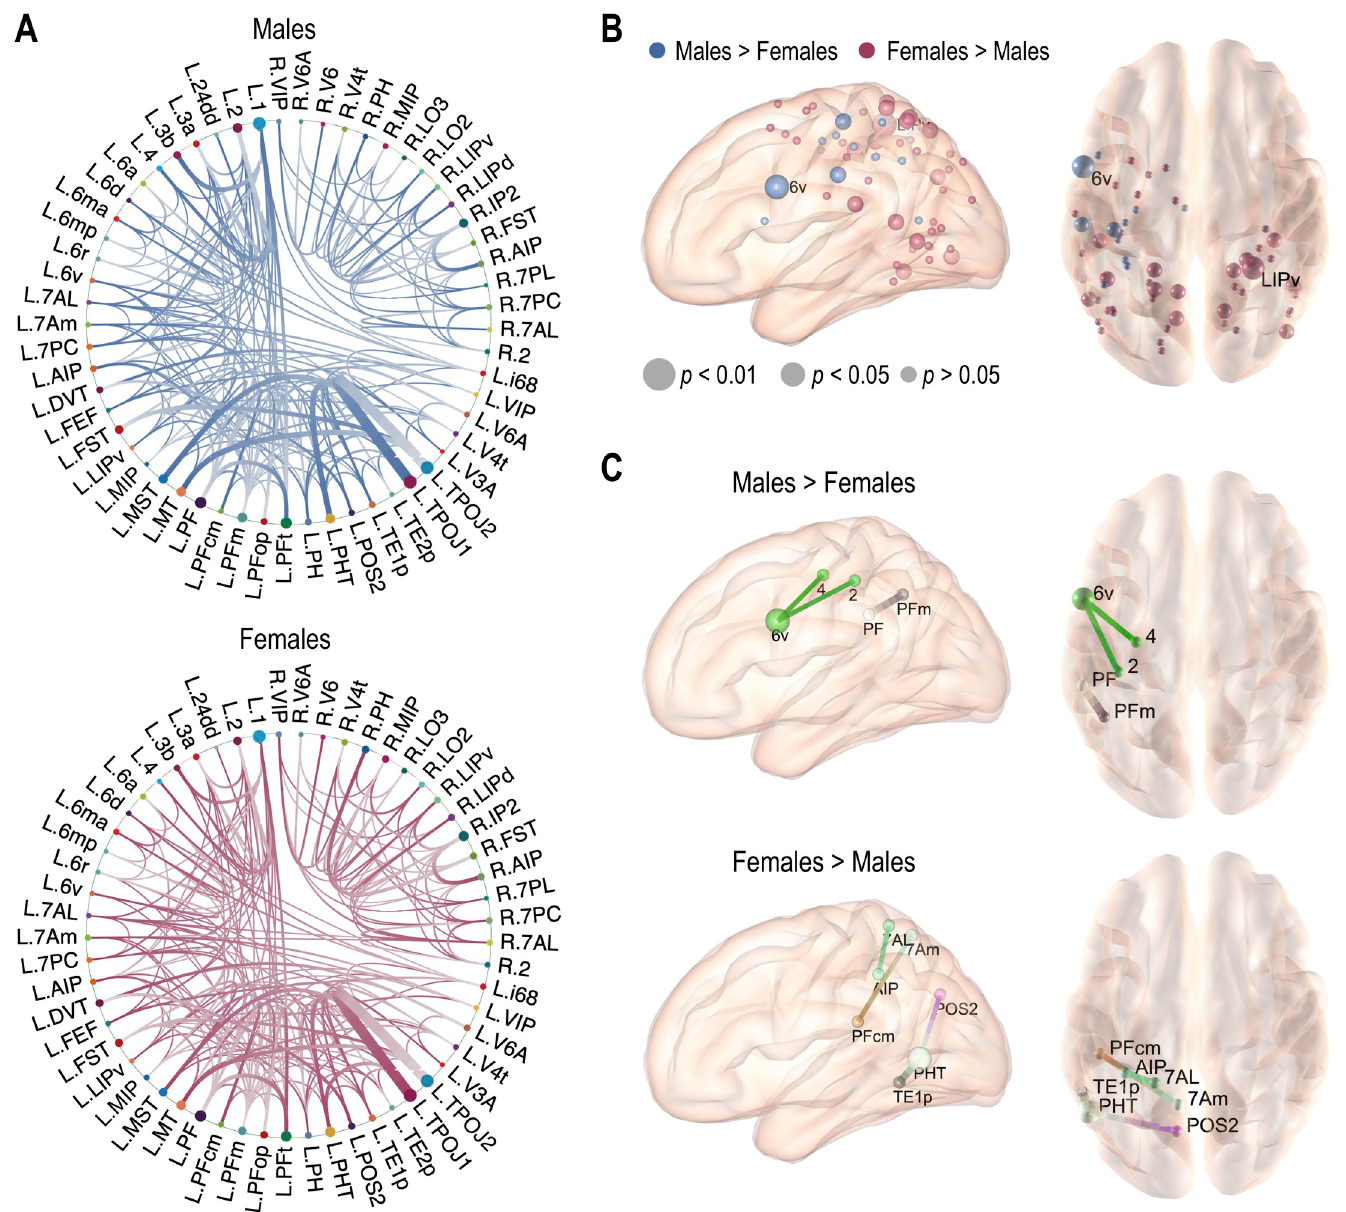
Fig 2. Structural connectivity differences between males and females. (A) Structural connectivity in the object manipulation network in males and females. Significant differences in node strength (B) and edge strength (C) between males and females (two-sample t -tests). https://doi.org/10.1371/journal.pone.0253273.g002 related regions were higher in males than females, whereas in the parietal and temporal regions, they were higher in females than males. Edge strengths of the left ventral premotor cortex (6v) with the primary motor cortex (4) and S1 primary somatosensory complex (2) and between the left inferior parietal cortical regions (PF and PFm) were significantly higher in males than females. However, edge strengths between the paracentral lobule, inferior and superior parietal cortices, middle temporal complex (MT+) and neighboring visual areas, and dorsal stream visual cortex were significantly higher in females than males (Fig 2C). The statis- tical group differences are summarized in S1 and S2 Tables.